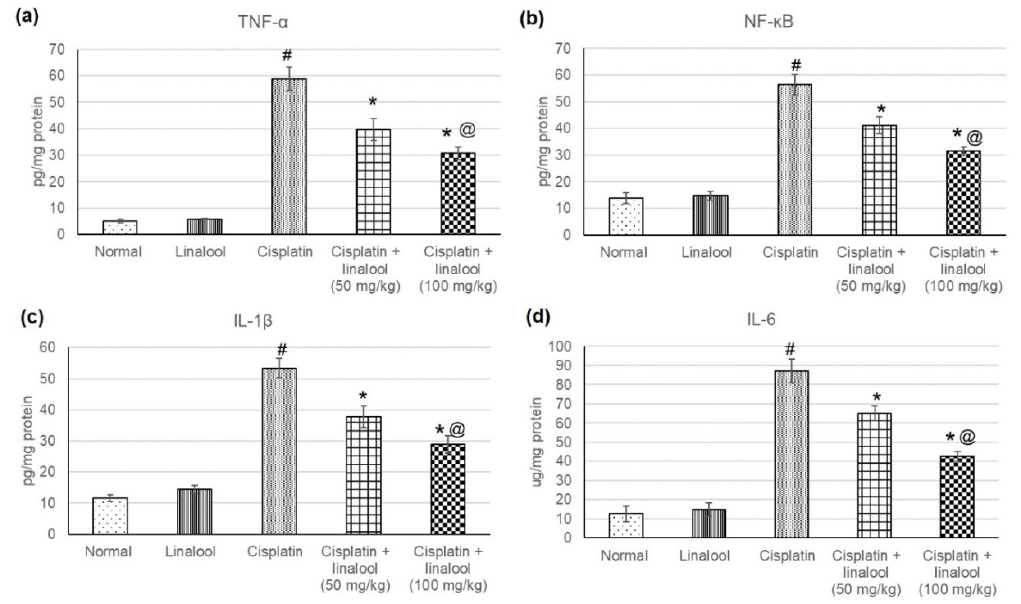
Figure 3. Effects of pre-treatment with linalool (50 and 100 mg/kg) for 14 days on the TLR pathway gene expression (mRNA amplification) ( a ) TLR4, ( b ) MyD88, and ( c ) TRIF, and TLR pathway proteins’ expression ( d ) TLR4, ( e ) MYD88, and ( f ) TRIF in cisplatin-induced acute kidney injury. All values are expressed as mean ± SD. # indicates statistically significant compared with the normal control group, * indicates statistically significant from the cisplatin-only group, and @ indicates statistically significant from the cisplatin + linalool 50 mg/kg group ( p < 0.05) using one-way ANOVA followed by Tukey’s post-hoc analysis.